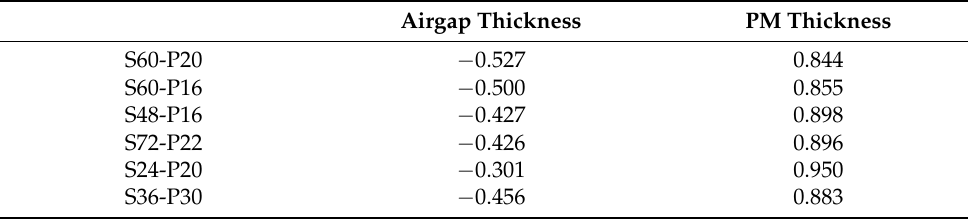
Table 3. Correlation analysis of airgap thickness and PM thickness with the AC